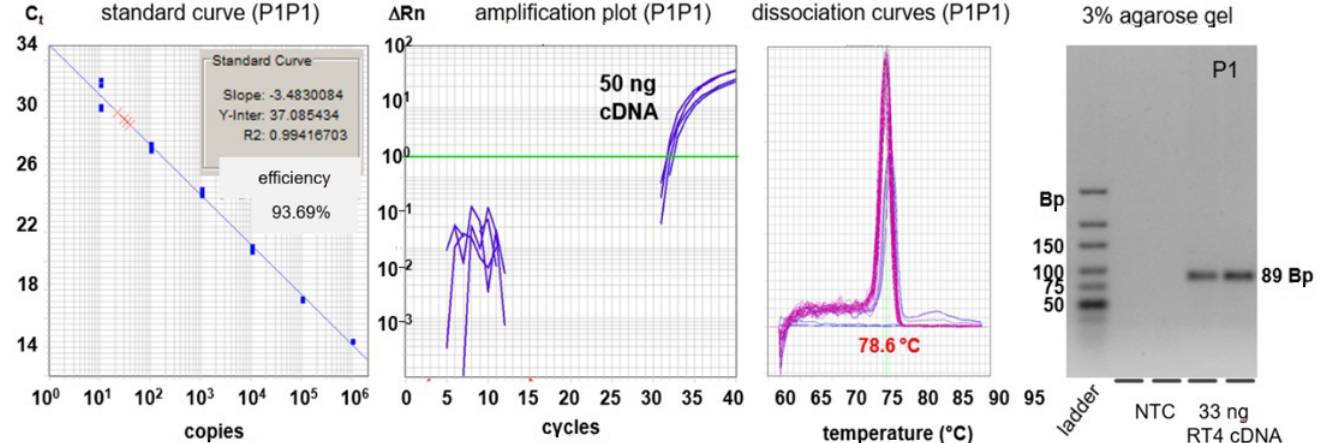
Figure 6. Experimental evaluation of selected PCR amplicons, i.e., primer pair P1 (see Figure 5). Left panel, standard dilution curve of cloned KRT20 (plasmid pCRII-KRT20P1P1); middle left panel, amplification plots of cDNA prepared from RT-4 cells; middle right panel, dissociation curve of the amplification product; right panel, gel analysis of the amplification product that shows the calculated size of 89 base pairs (abbreviation: NTC: non template control).